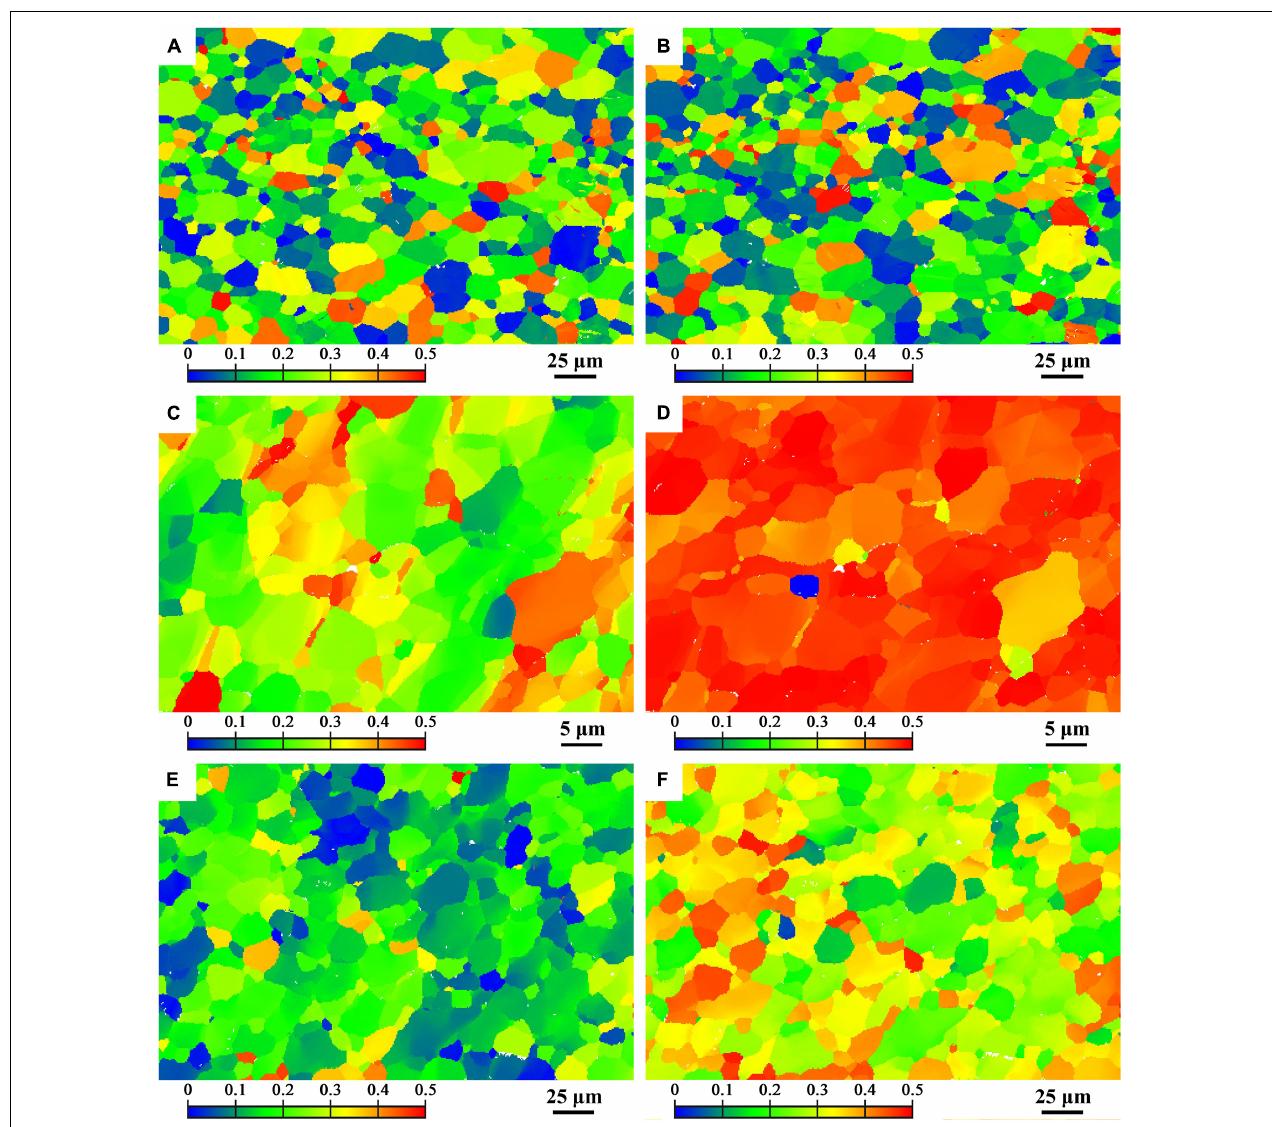
FIGURE 7 | Schmid factor distribution map of TD (on the left side) and PD (on the right side) of (0001) basal slip system (A,B) BM, (C,D) FSP, (E,F) FSP-ZrO 2